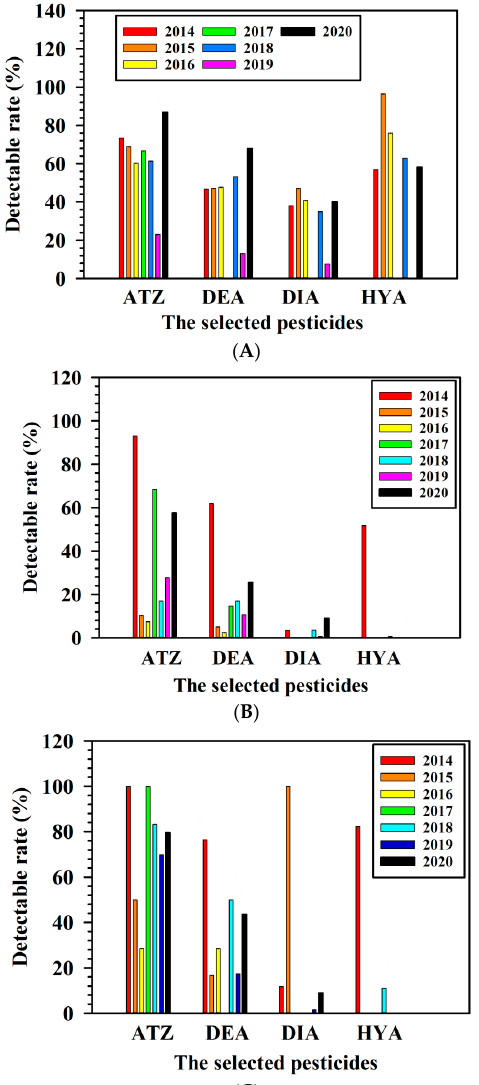
Figure 2. Detectable rate of the analytes in ( A ) soil samples; ( B ) groundwater samples; ( C ) surface water samples.